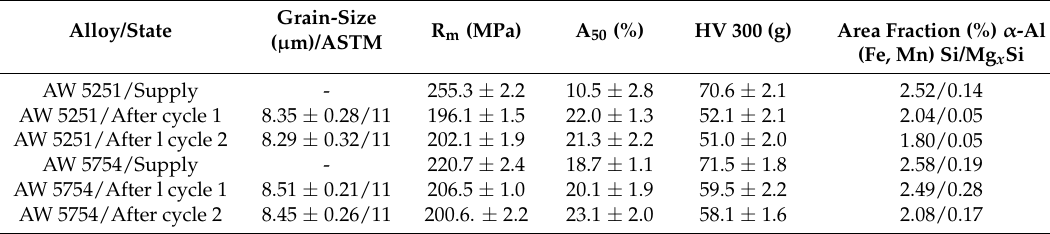
Figure 4. Stress–strain curves: AW 5241 supply ( a ), AW 5251 after cycle 1 ( b ), AW 5251 after cycle 2 ( c ), AW 5754 supply ( d ), AW 5754 after cycle 1 ( e ), and AW 5754 after cycle 2 ( f ). Table 2. ASTM grain size, tensile strength (R m ), elongation rupture point (A 50 ), Vickers hardness (HV) and % constituent particles on EN AW 5251 and EN AW 5754.